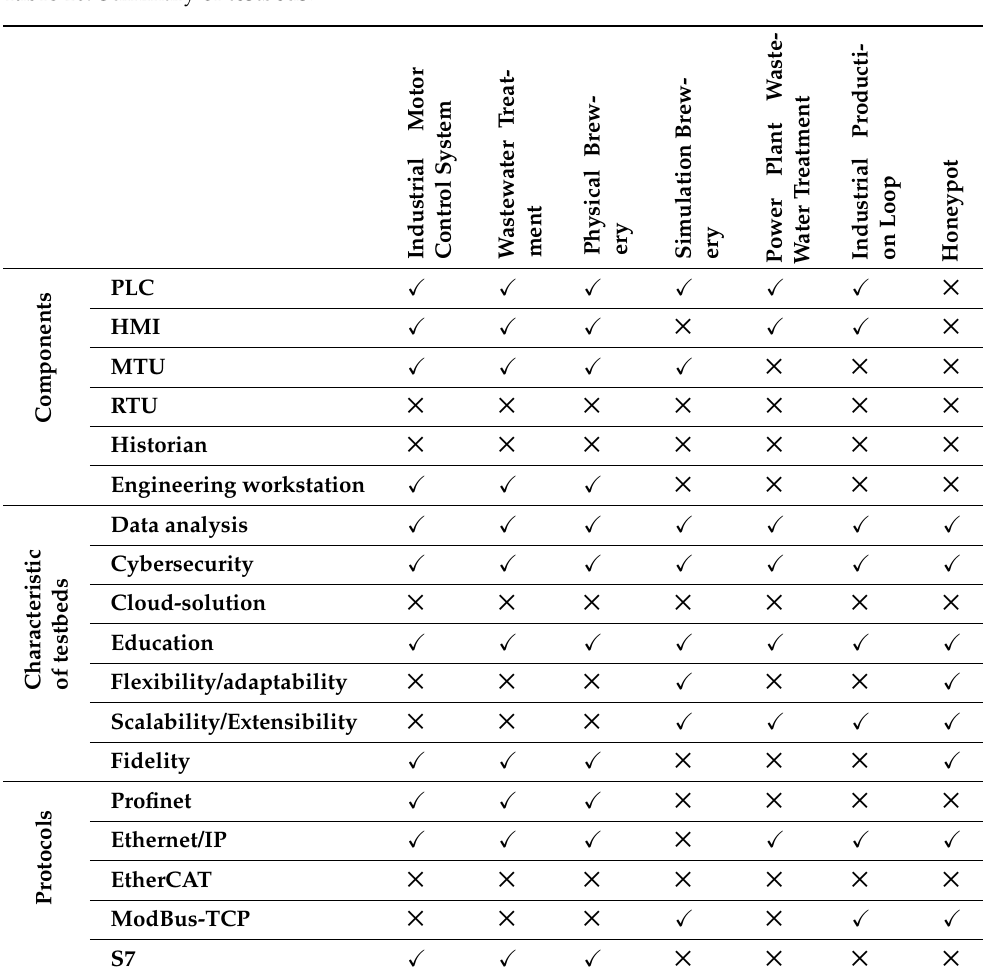
Table 10. Summary of